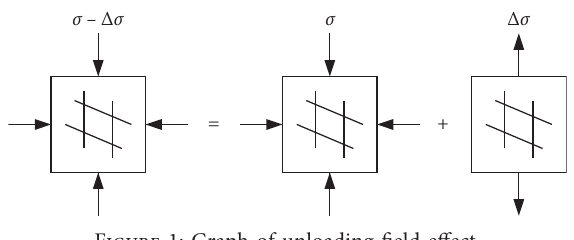
Figure 1: Graph of unloading field